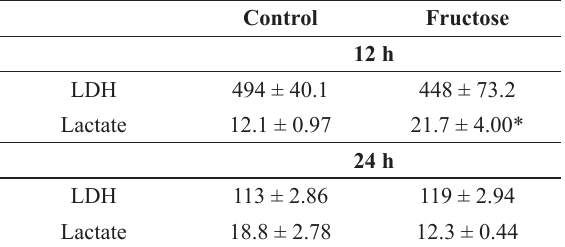
Lactate dehydrogenase (LDH) and lactate levels in serum of animals submitted to an animal model of fructosemia.